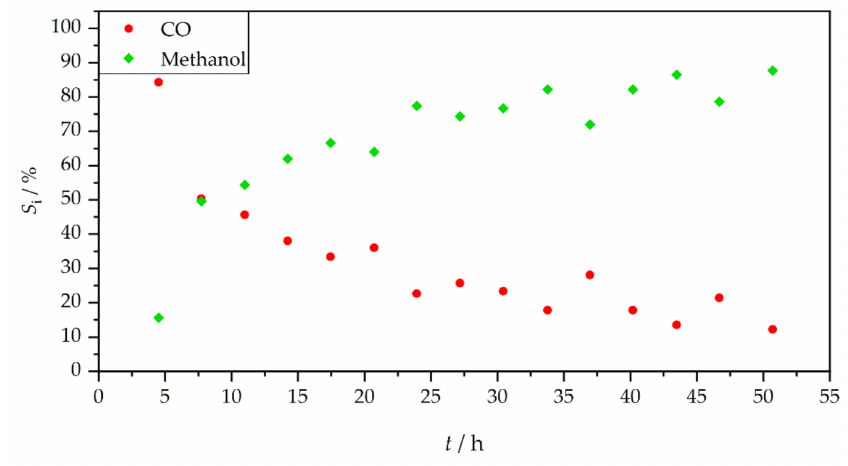
Figure 8. Interval selectivities of CO and methanol during the experimental